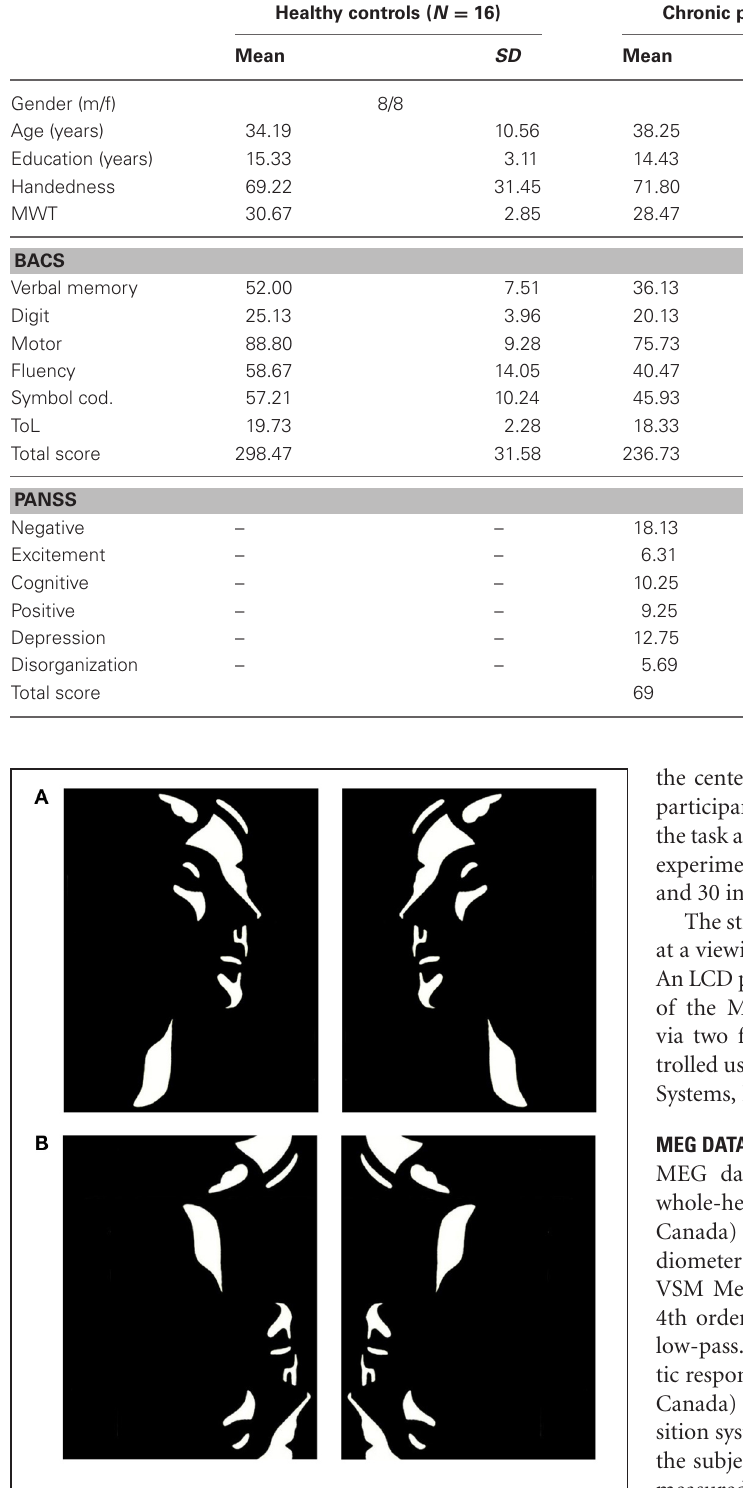
FIGURE 1 | Examples of upright (A) and inverted-scrambled (B) Mooney face stimuli.